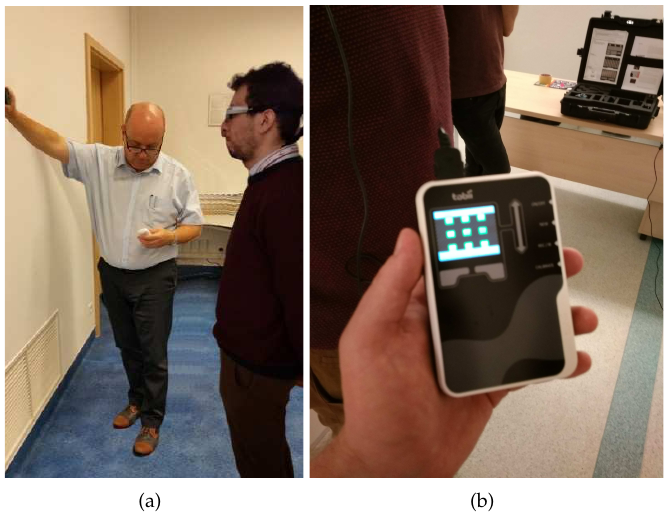
Figure 5. ( a ) Calibration with the IR marker; ( b ) precise calibration, no repetition